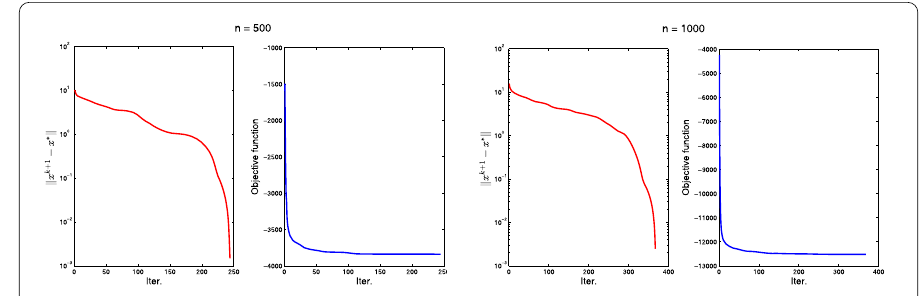
Figure 1 Evolutions of the value of (cid:7) x k +1 – x ∗ (cid:7) and the objective function value with respect to the number of iterations for n = 500 and n =